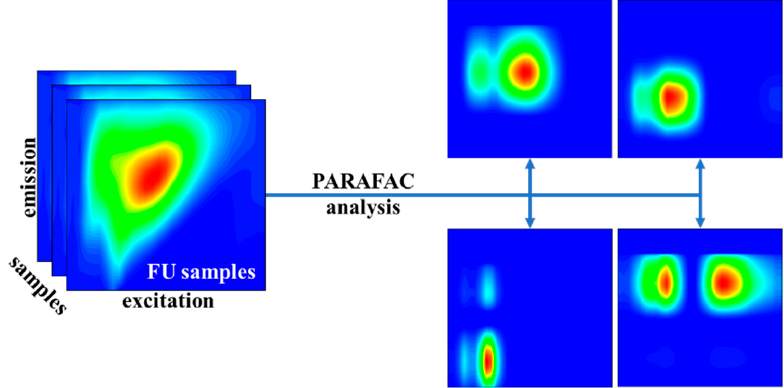
Figure 3. 3D-EEMs are decomposed into PARAFAC components.